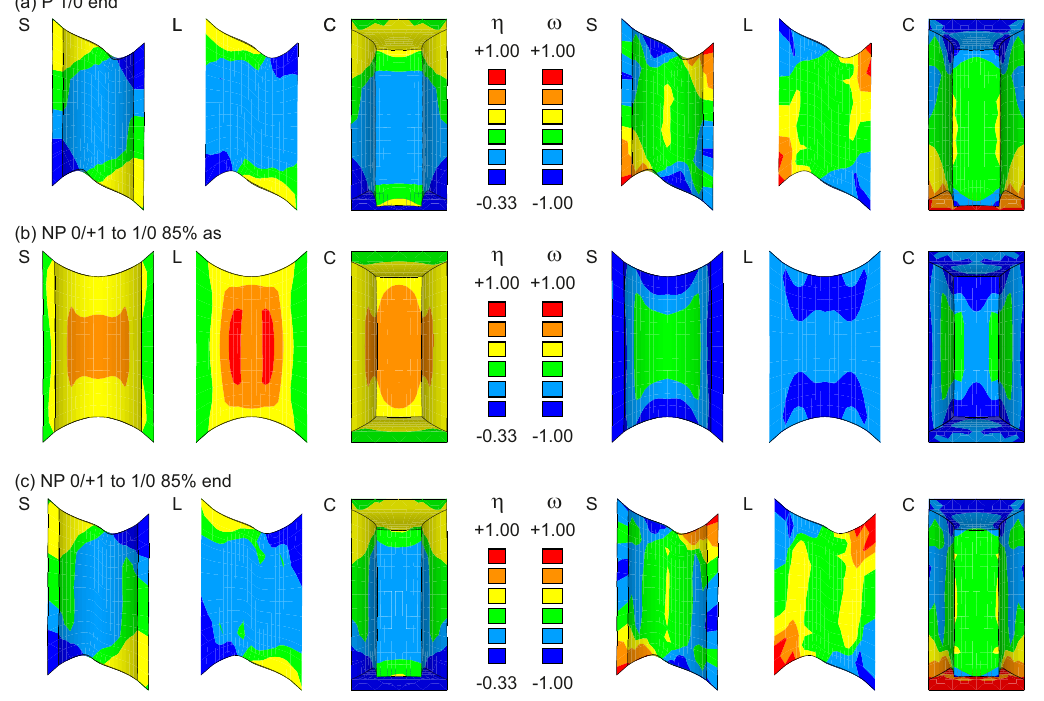
Figure 7. Stress triaxiality η and Lode parameter ω : S—surface, L—longitudinal section, C—cross